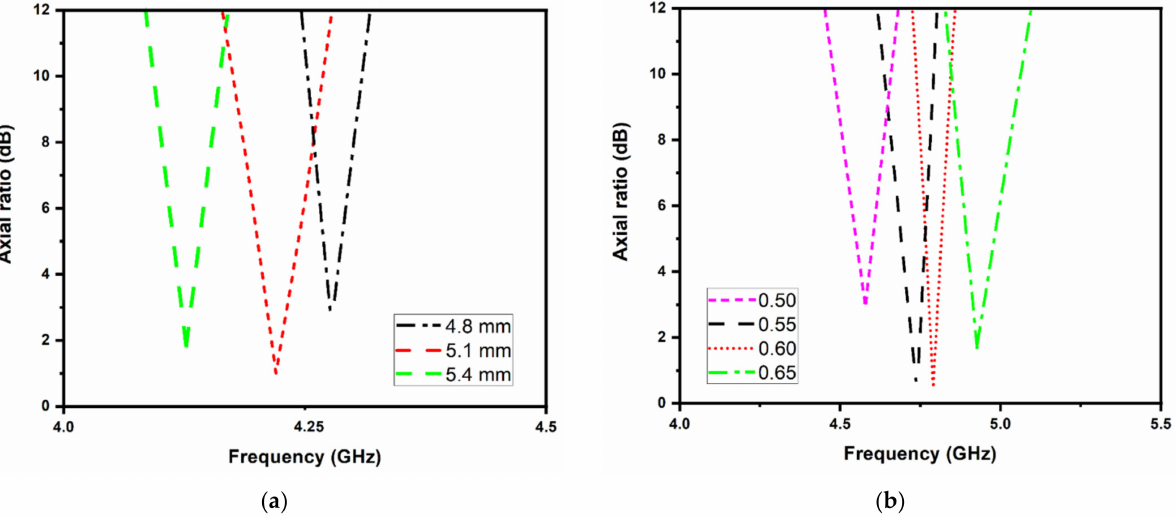
Figure 4. Effect of the antenna dimensions on axial ratio; ( a ) square patch truncation ( R ); ( b ) ellipticity ( c